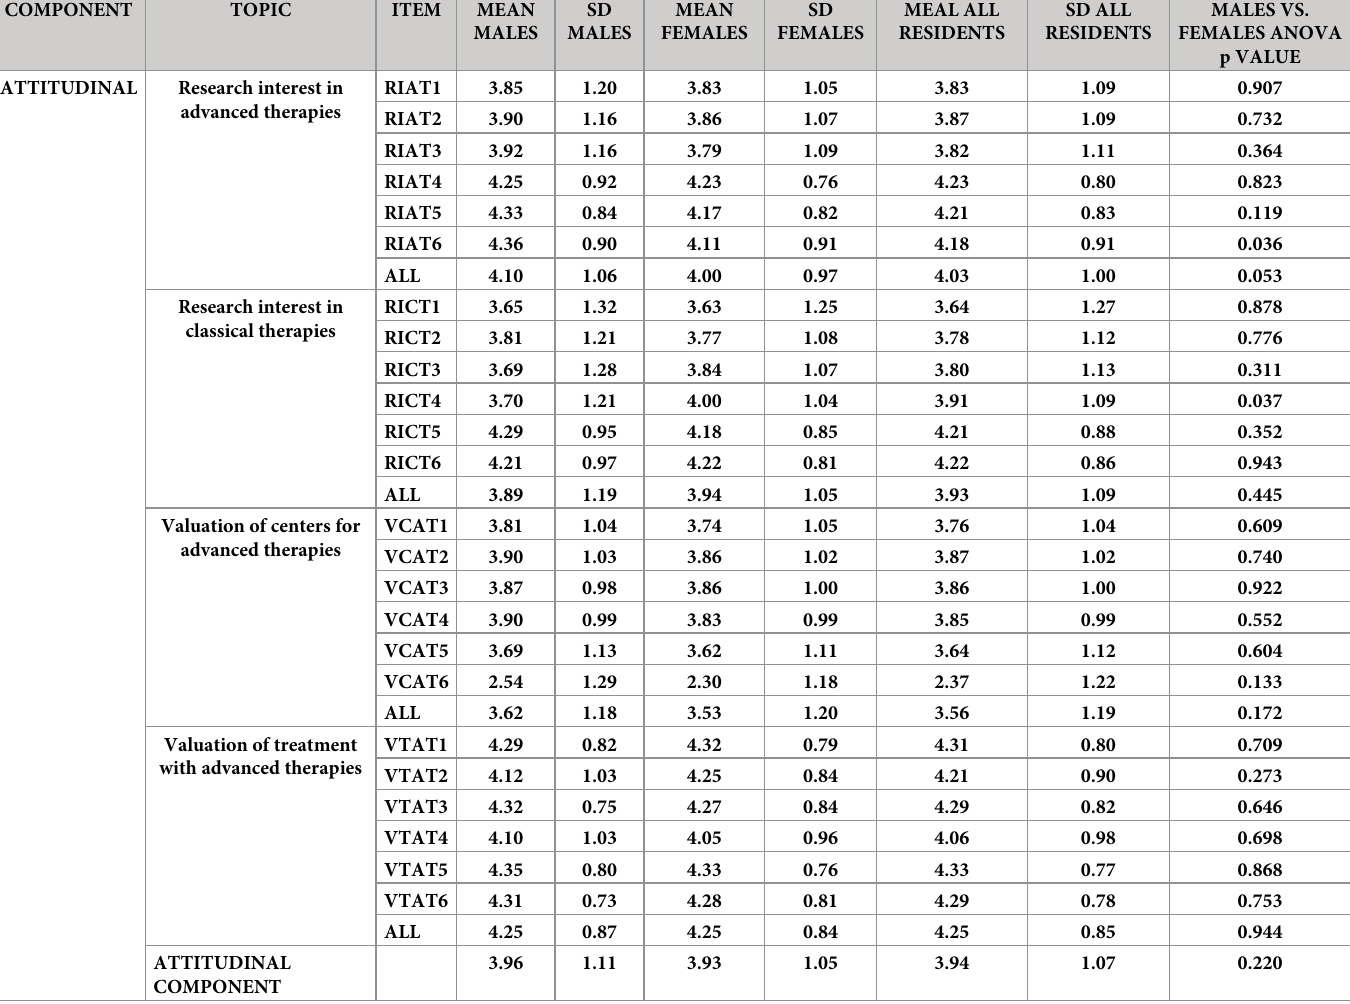
Table 4. Mean values and standard deviations (SD) for the attitudinal component and for each topic and each item included in this component. In each case, results are shown for male and female residents separately, and for all residents together. The last column shows the statistical p value for ANOVA comparisons between genders. COMPONENT TOPIC